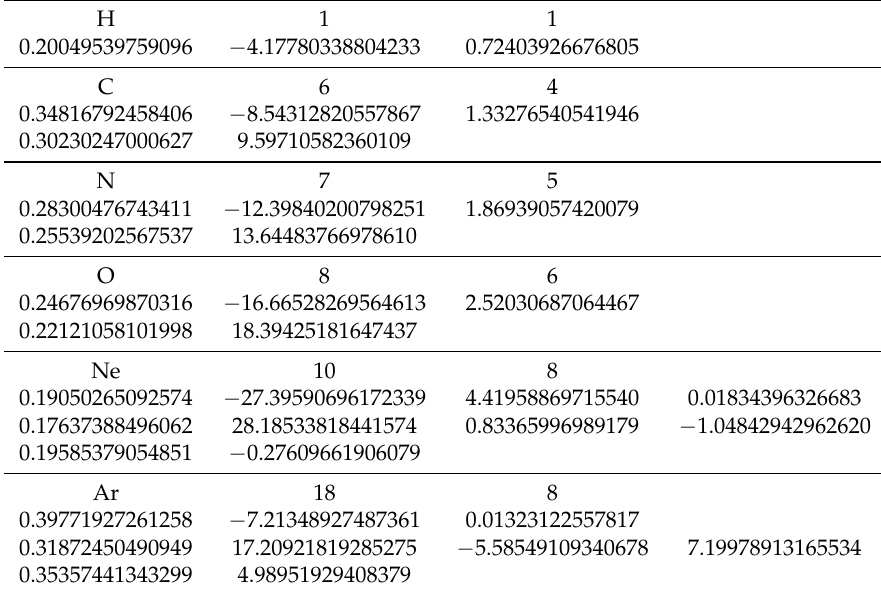
Table A3. Hartree-Fock pseudopotential parameters. The format corresponds to [78]. Pseudopotentials are taken from